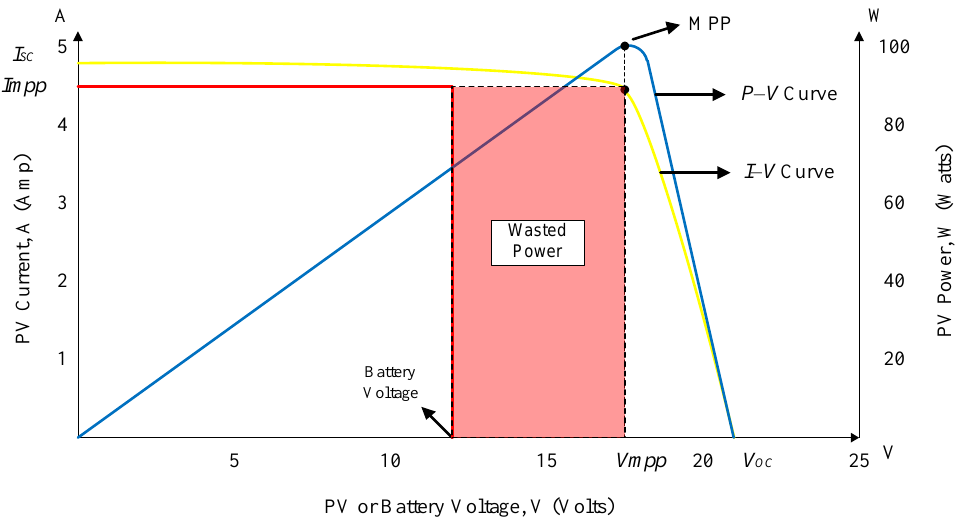
Figure 6. Graph of PV array battery charging power transfer.